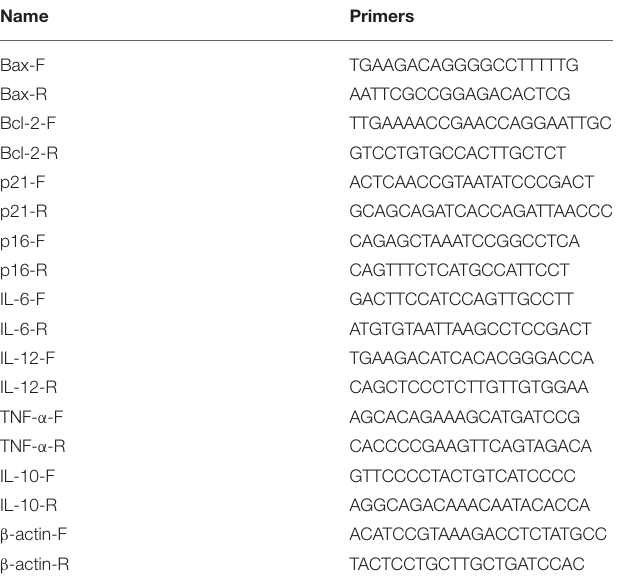
TABLE 1 | The primers used in this